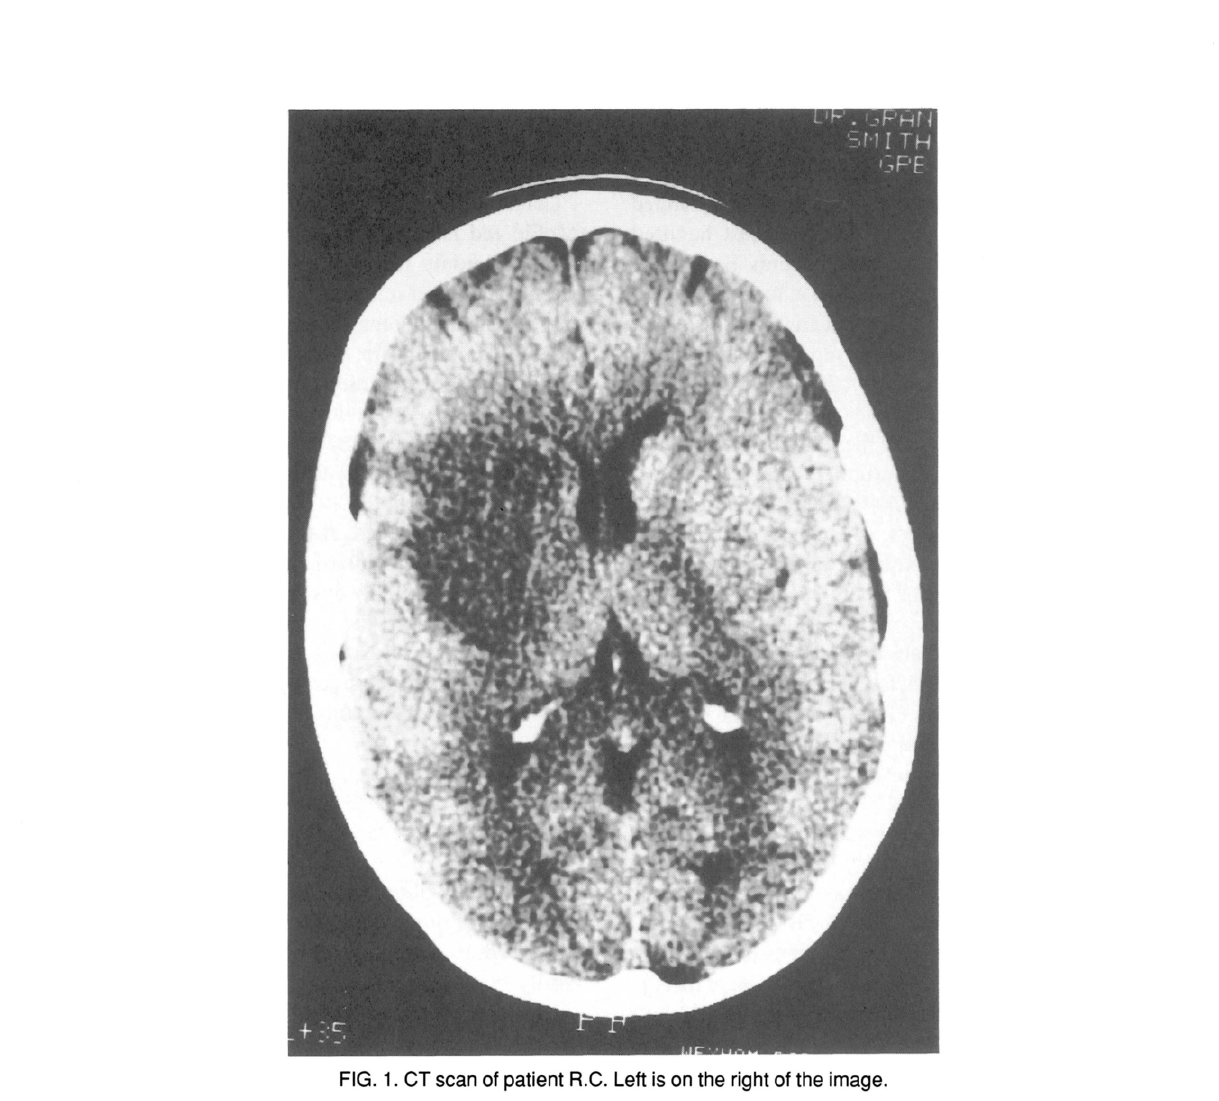
FIG. 1. CT scan of patient R.C. Left is on the right of the